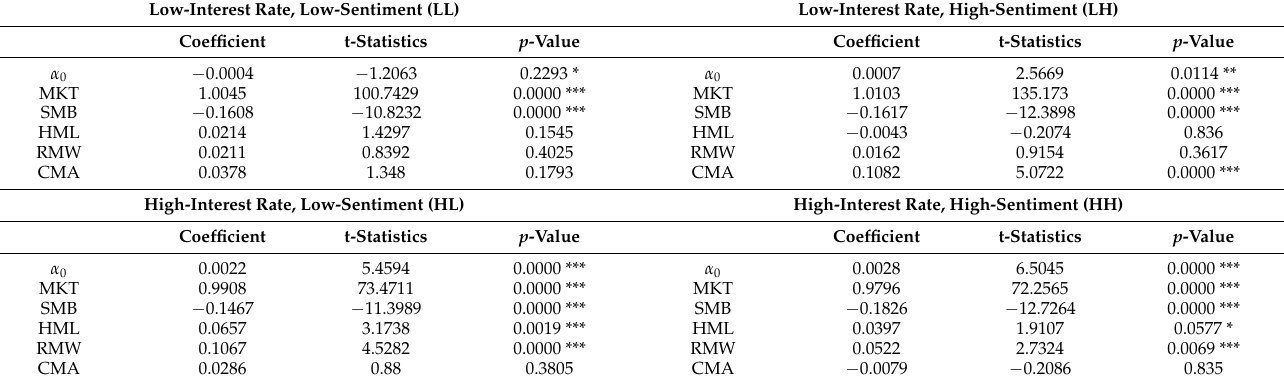
Table 5. Five-factor adjusted stock returns in market cycles (real interest rate and market sentiment). The table reports five-factor adjusted returns of the S&P 500 in the four market cycles for Equation (8). The median of long-term real interest rate is 2.42%, greater than (less than) the median defined as a high-interest rate (low-interest rate) cycle; the median of market sentiment is 0.03, greater than (less than) the median defined as a high-sentiment (low-sentiment) cycle. Adjusted R-square: 0.9894 (LL), 0.9943 (LH), 0.9896 (HL), 0.9899 (HH). All t-statistics are based on the Heteroskedasticity- Autocorrelation-Consistent standard errors. *, **, and *** denote significance at the 10%, 5%, and 1% levels,